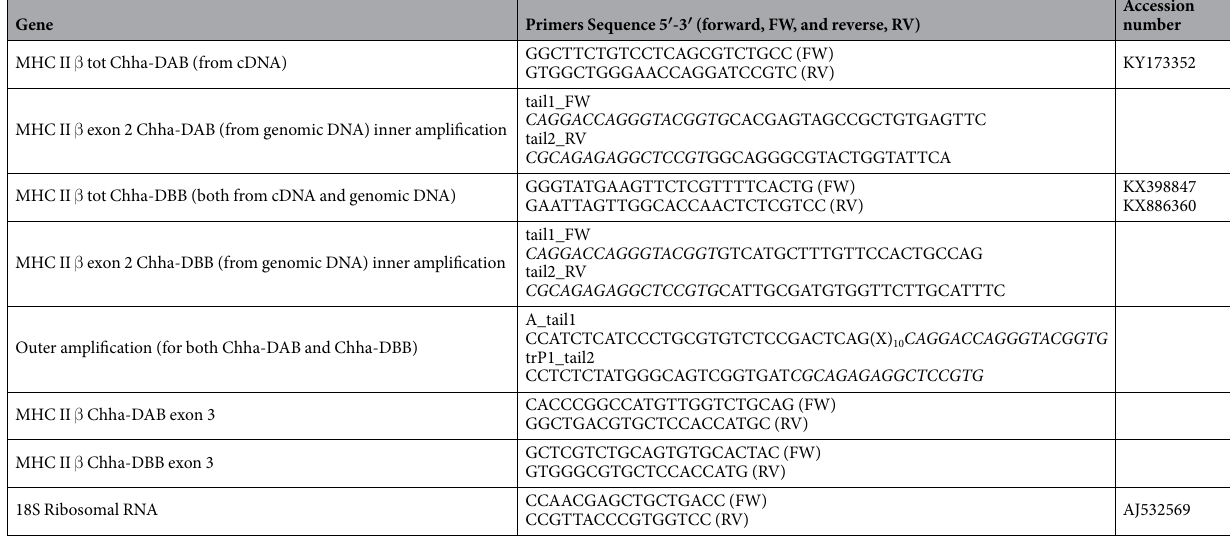
Table 1. Primers used for MHC II β cloning, sequencing and expression analysis. Italicised letters correspond to the tail added to the exon 2 specific